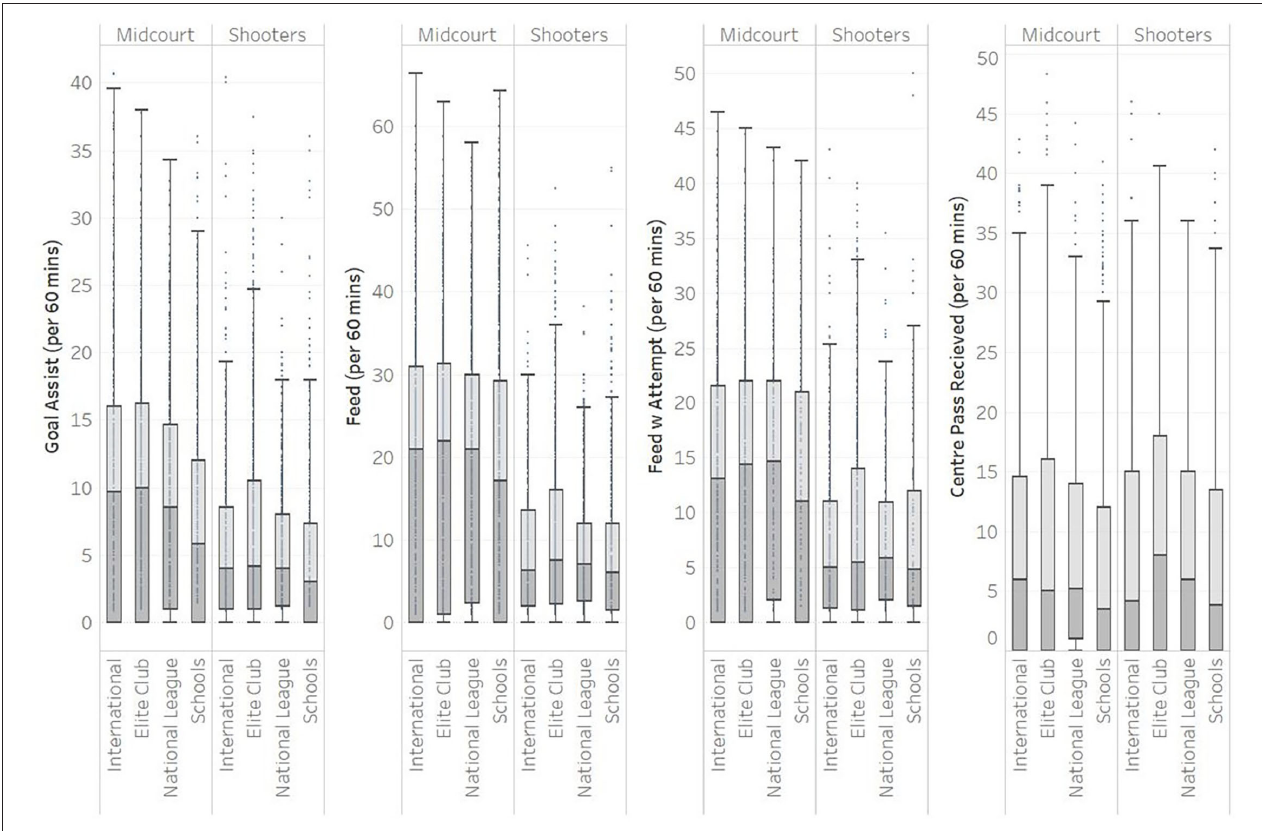
FIGURE 4 | Box and whisker plots of various level of netballs normative data for general play attack